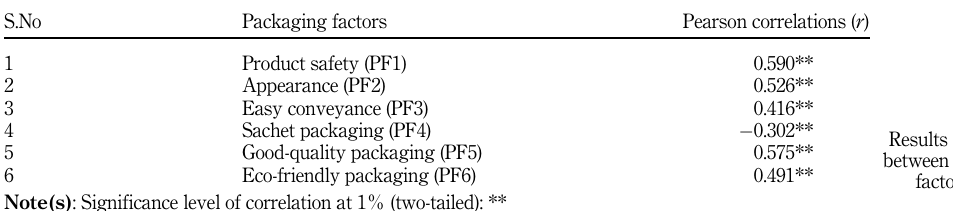
Table 10. Results of correlations